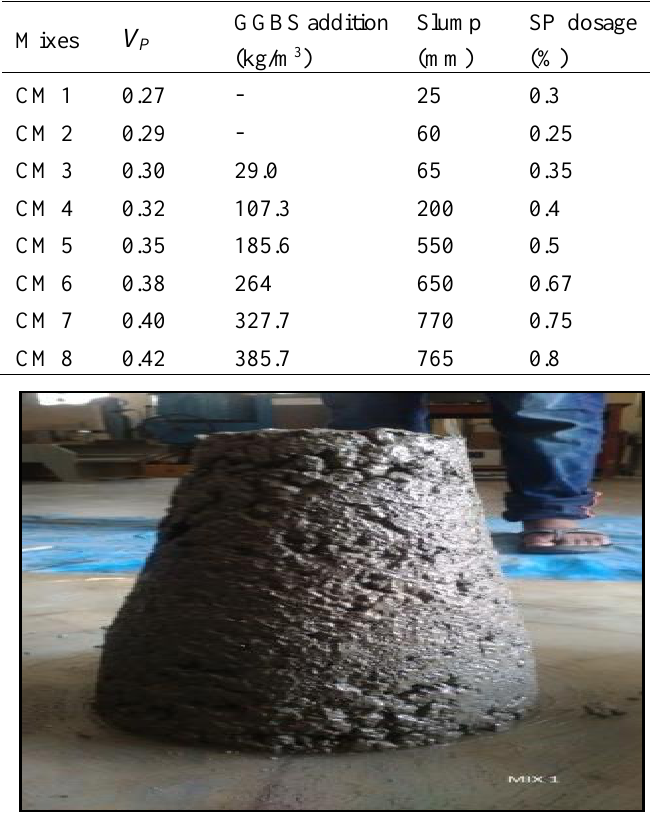
Fig. 7. Slump loss of CM